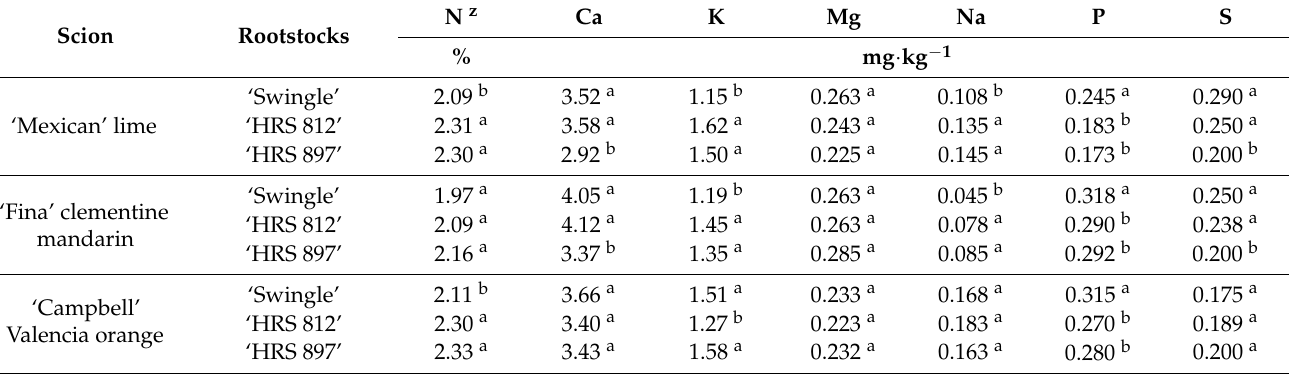
Table 2. Mean concentrations of leaf tissue nutrients in 2021 of three citrus cultivars grafted in three different rootstocks and growing under fertigation practices on Coto series soil at the Agricultural Experiment Station of Isabela, Puerto Rico.